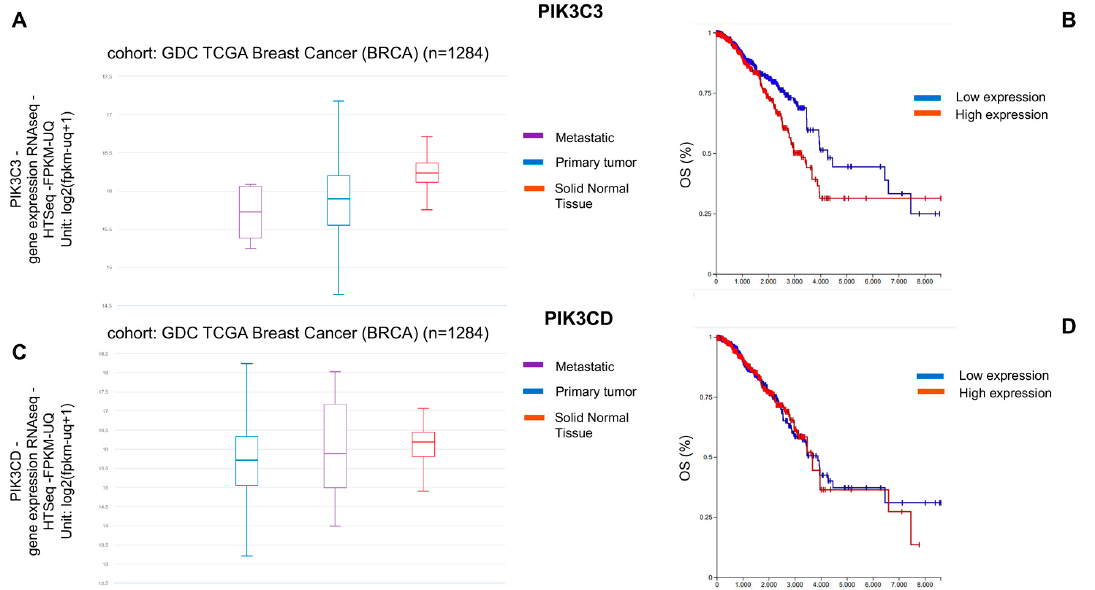
Figure 1. PIK3C3 and PIK3CD gene expression levels in normal mammary tissues and in BC specimens. Correlation between PIK3C3 and PIK3CD gene expression levels and overall survival (OS) in BC patients. The TCGA dataset including 1284 breast samples was used to investigate PIK3C3 and PIK3CD gene expression levels. ( A ) PIK3C3 was expressed in metastatic lesions (violet), in primary tumours (blue), and in solid normal tissue (red) at different levels (metastatic < primary tumour < solid normal tissue). ( B ) High PIK3C3 expression levels (red) were found correlated with a reduced percentage of OS in BC patients. ( C ) PIK3CD was expressed in metastatic lesions (violet), in primary tumours (blue), and in solid normal tissue (red) at different levels (primary tumour < metastatic < solid normal tissue). ( D ) High PIK3C3 expression levels (red) were found correlated with a reduced percentage of OS in BC